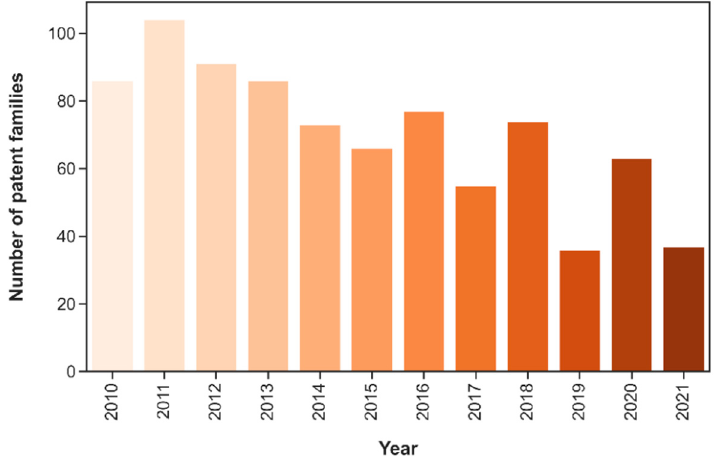
Figure 4. Patent development trend of e-fuel technology. (Note: The x-axis represents the priority year, while the y-axis represents the number of patent families).